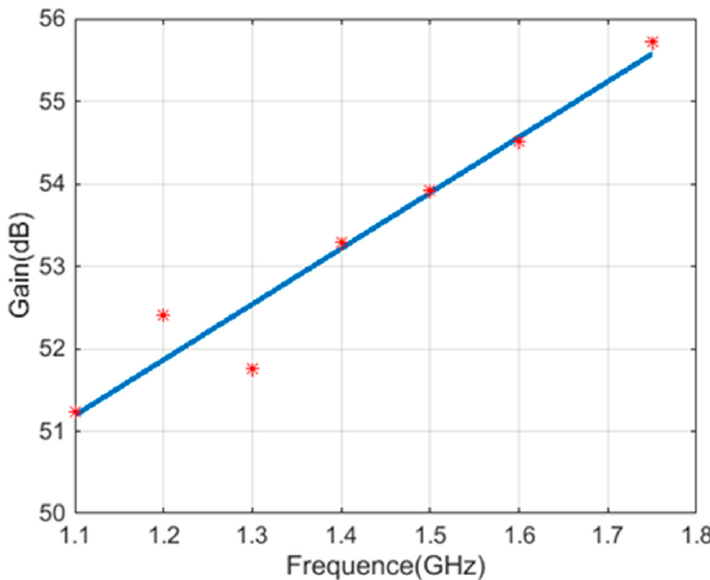
Figure 3. Gain curve of 40 m dish antenna: antenna gain obtained by the radio power test method (red pots) and the linear fitting result of the actual measurement (blue